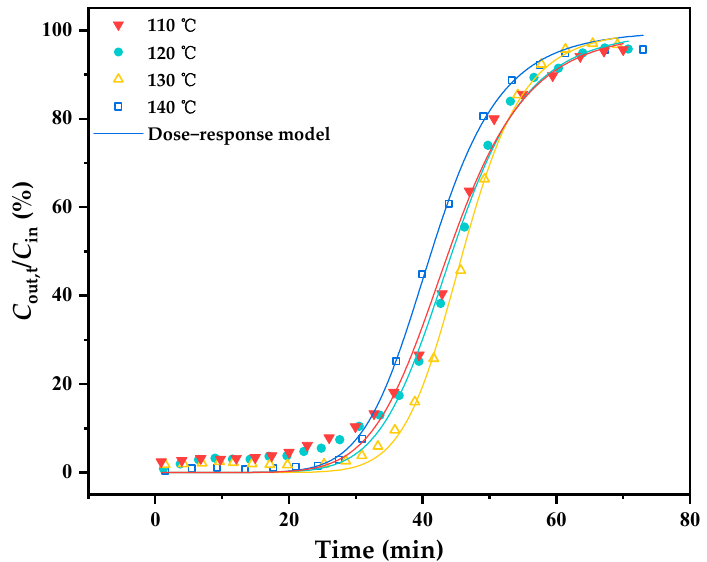
Figure 1. Plots of anisole removal ratios ( X a ) vs. temperature ( T ).